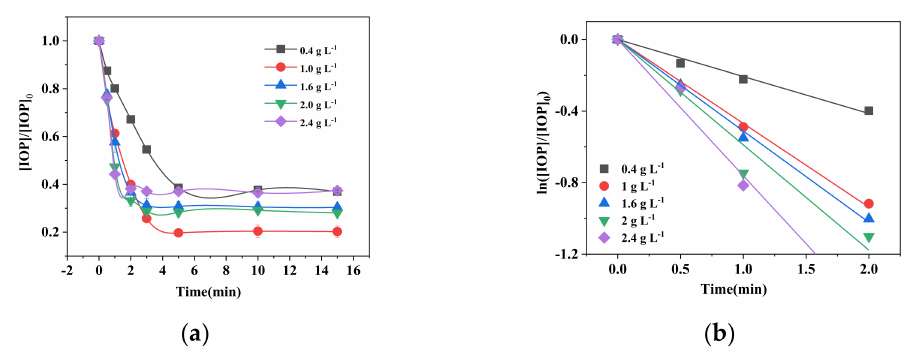
Figure 4. ( a ) Effect of initial FeS dosage on the degradation of IOP by FeS/sulfite system in 15 min. ( b ) Obvious reaction kinetics in first 2 min. Conditions: [IOP] 0 = 1.5 mg L − 1 , [FeS] 0 = 0.2–2.4 g L − 1 , [Na 2 SO 3 ] 0 =400 µ mol L − 1 , pH init =